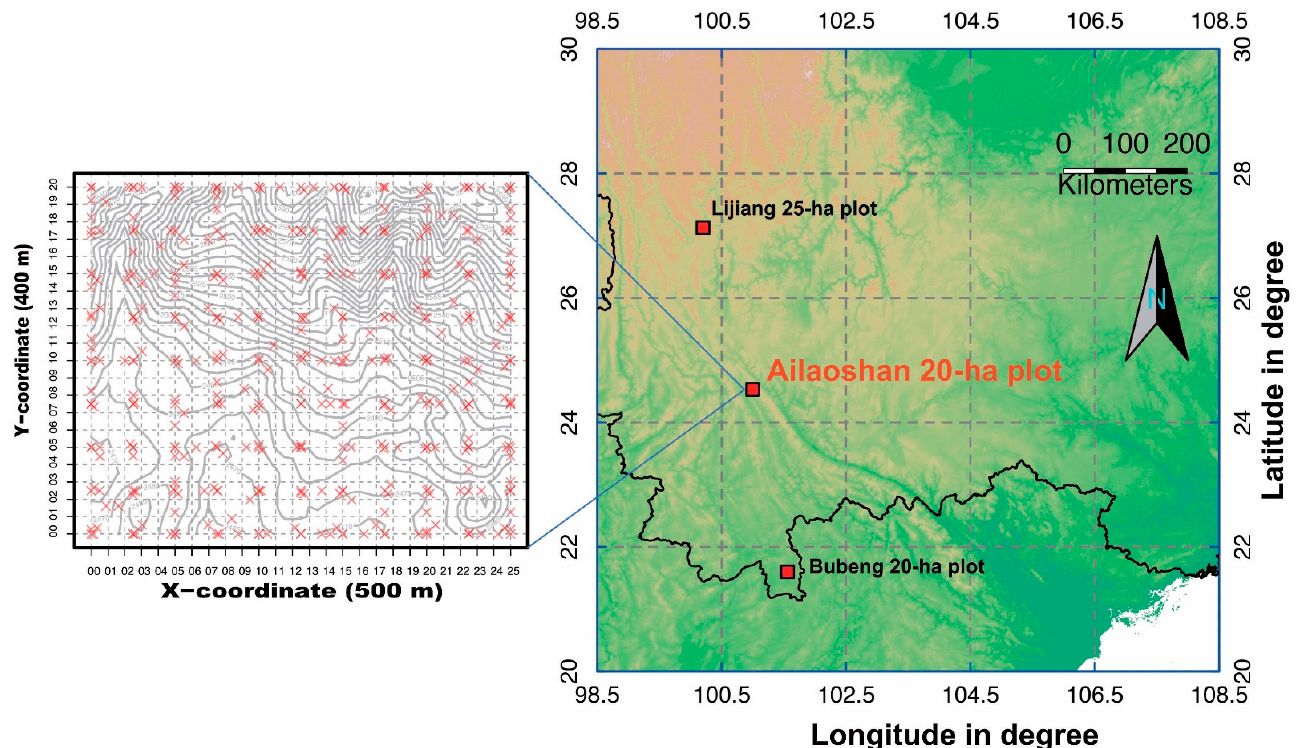
Figure 1. The location and distribution of soil samples ( left ) in the 20 ha Ailaoshan forest dynamics plot ( right ) in Southwest China. The red crosses in the left panel represent the soil samples. Grey lines are contour lines.